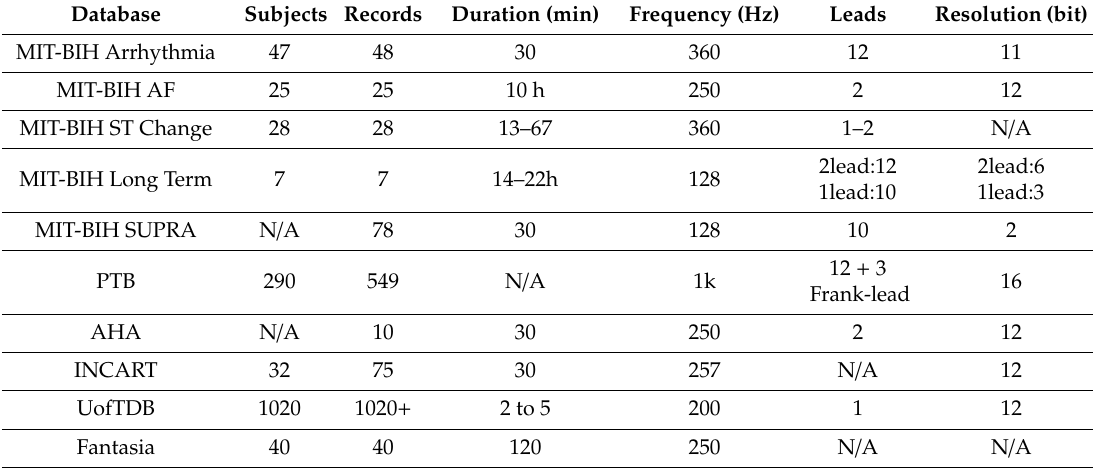
Table 3. Brief description of ECG databases